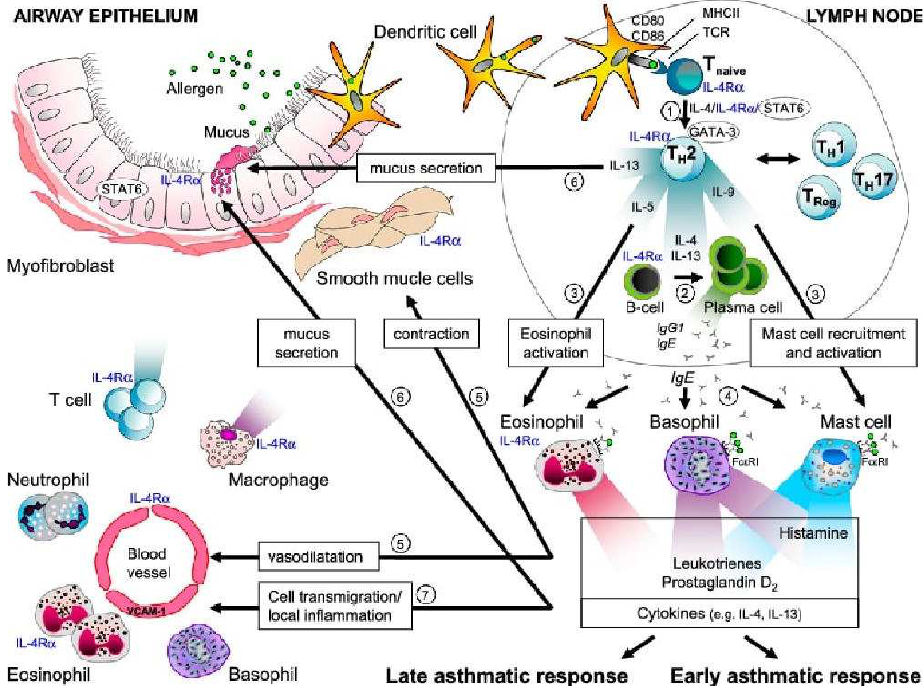
Figure 2. Role of IL-4 in asthma and allergy. Arrow 1 shows the role of IL-4 in the differentiation of T cells into Th2 cells. Arrow 2 shows the class-switching isotype of B cells that synthesize IgE, which is mediated by IL-4 and IL-13. Arrow 3 shows the effect of IL-5 on eosinophils and that of IL-9 on mast cell function. Arrow 4 indicates that IgE produced by plasma cells binds to the IgE receptors on mast cells, basophils, and eosinophils. Upon allergen exposure, IgE crosslinking causes an immediate release of histamine, leukotrienes, and prostaglandins (after a few minutes) and the production of other cytokines (after a few hours). Arrow 5 shows that histamine, leukotrienes, and prostaglandins induce smooth muscle contractions and vasodilation. Arrow 6 indicates that cytokine IL-13, together with IL-4, causes mucus secretion and goblet cell hyperplasia. Arrow 7 shows that IL-4 and IL-13 contribute to the recruitment of inflammatory cells by upregulating the expression of VCAM-1, which facilitates the transmigration of eosinophils, T cells, monocytes, and basophils in response to chemokines produced by mast cells (the late asthma response) [39]. AHR, airway hyperresponsiveness; Fc ε RI, Fc epsilon RI, high-affinity receptor for the Fc region of immunoglobulin E (IgE); IL-4Ra, interleukin-4 receptor a; Stat6, signal transducer and activator of transcription 6. Reprinted with permission from Ref. [39]. Copyright 2022 American Thoracic Society.IL-4 is the main cytokine in the sequential development of allergic inflammatory reactions. It mediates an important proinflammatory function in asthma by inducing IgE isotype switch and IgE secretion via B lymphocytes and vascular cell adhesion molecule-1 (VCAM-1) expression, increasing eosinophil transmigration through the endothelium, mucus production, and Th2 lymphocyte differentiation and promoting cytokine release. IL-4 increases IgE-mediated immune responses by regulating IgE receptors, namely the low-affinity IgE receptor (Fc ε RII or CD23+) on B lymphocytes, mononuclear phagocytic cells, and the high-affinity IgE receptor (Fc ε RI) on mast cells and basophils. IL-4 contributes to airway obstruction in asthma by inducing mucin gene expression and increasing mucus secretion and other inflammatory cytokines from fibroblasts, which contribute to the inflammatory process and pulmonary remodeling [39].